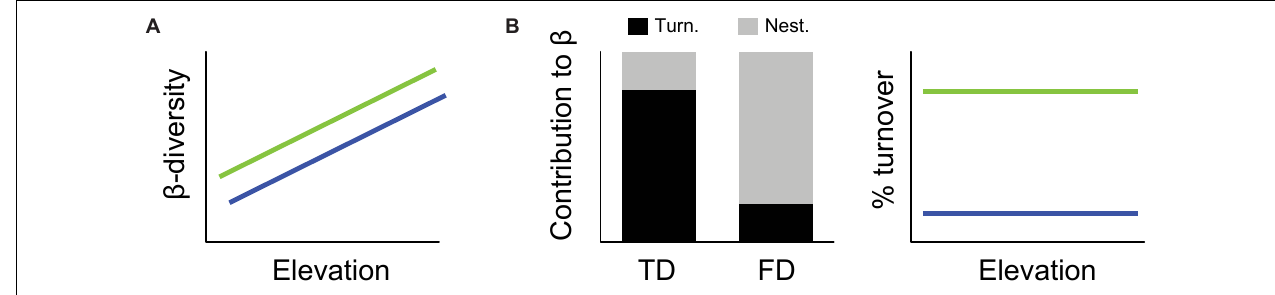
FIGURE 1 | Hypotheses of how temporal β -diversity and its turnover contribution varies in an elevational gradient. (A) Our first hypothesis is that both taxonomic (green line) and functional (blue line) temporal β -diversities increase with elevation, because in more harsh, higher elevation environments, the temporal variation in conditions and resources would be higher. (B) Our second hypothesis is that turnover (black bar) is the most important mechanism generating taxonomic temporal β -diversity (green line) and that nestedness (gray bar) is the most important component of functional temporal β -diversity (blue line) in general and along all the elevational gradient, because the communities would present functional redundancy over time.